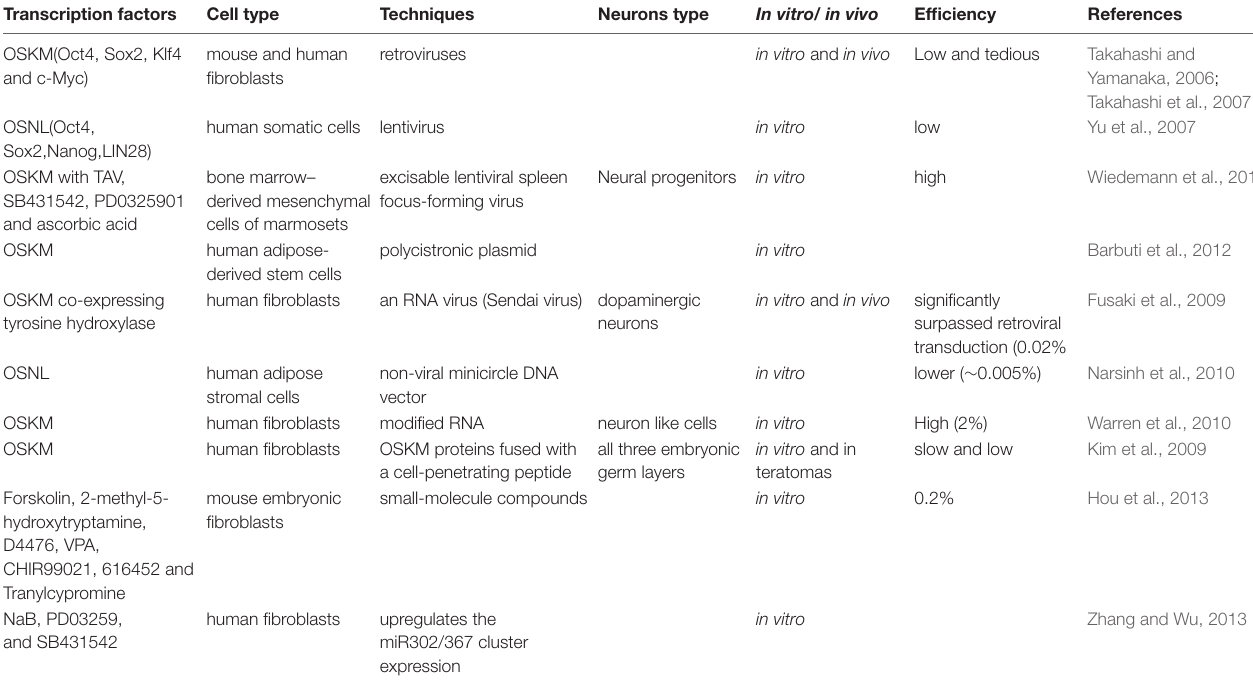
TABLE 1 | Neurons derived from iPSC